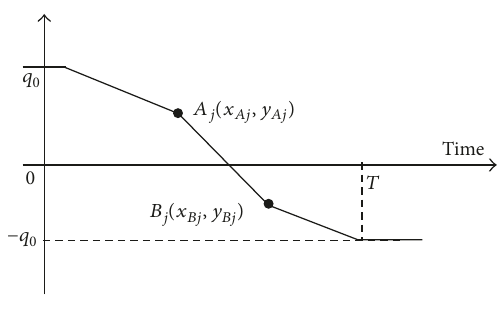
Figure 9: Reference trajectories 𝑞 𝑗𝑑 (𝑗 = 4, 5) .